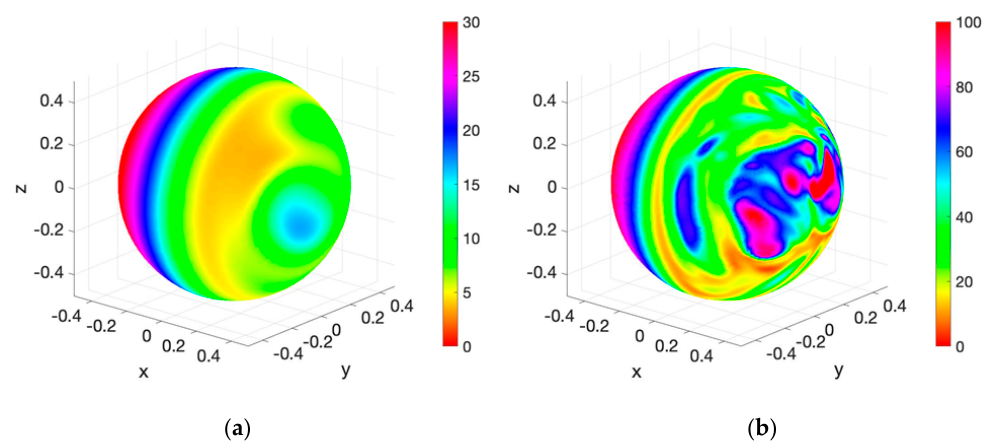
Figure 19. Instantaneous-local Nusselt number on the rear surface of the sphere obtained from direct numerical simulations (DNS) at Re = 1000 ( a ) and from LES at Re = 10,000 ( b ). The wind direction is parallel to the x -axis.